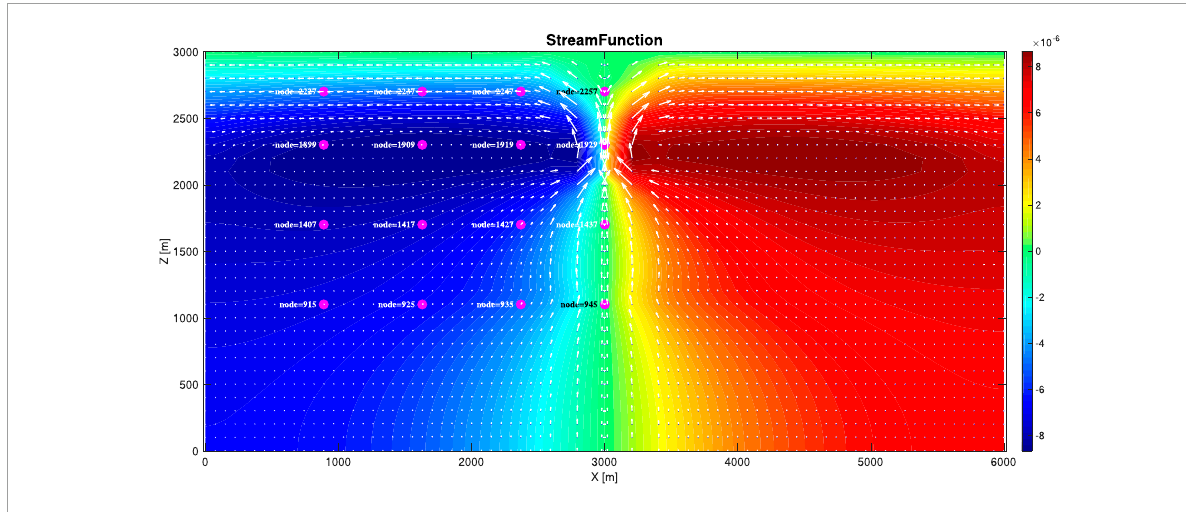
FIGURE 9 Stream function field in the Phlegraean Fields. Results of the analysis ( t fin ) .